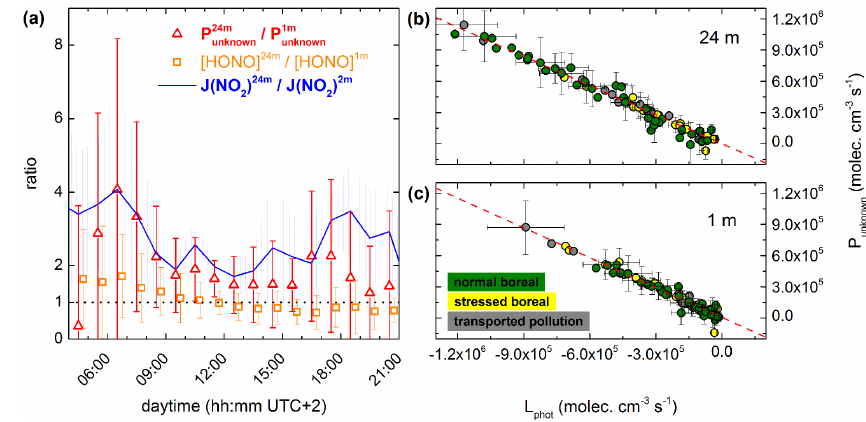
Figure 8. (a) The average ratio of P 24m to P 1m (red triangles), the average ratio of [HONO] 24m to [HONO] 1m (orange squares) unknown unknown and the average ratio of J( NO 2 ) 24m to J( NO 2 ) 2m (blue line) change during daytime (lifetime of HONO < 4h). For clarity, a second x- coordinate for the ratio of [HONO] 24m to [HONO] 1m is used with a shift of + 15min but is not shown. (b) P 24m and (c) P 1m unknown unknown are plotted against the photolytic loss rate of HONO at 24m and 1m above ground respectively. The York linear fit (York et al., 2004) of = − ( 0 . 93 ± 0 . 05 ) × L 24m + ( 0 . 9 ± 14 . 2 ) × 10 3 moleculescm − 3 s − 1 and P 24m with L 24m and P 1m with L 1m yields in P 24m unknown phot unknown phot unknown phot = − ( 0 . 96 ± 0 . 08 ) × L 1m + ( 0 . 6 ± 11 . 9 ) × 10 3 moleculescm − 3 s − 1 P 1m unknown phot